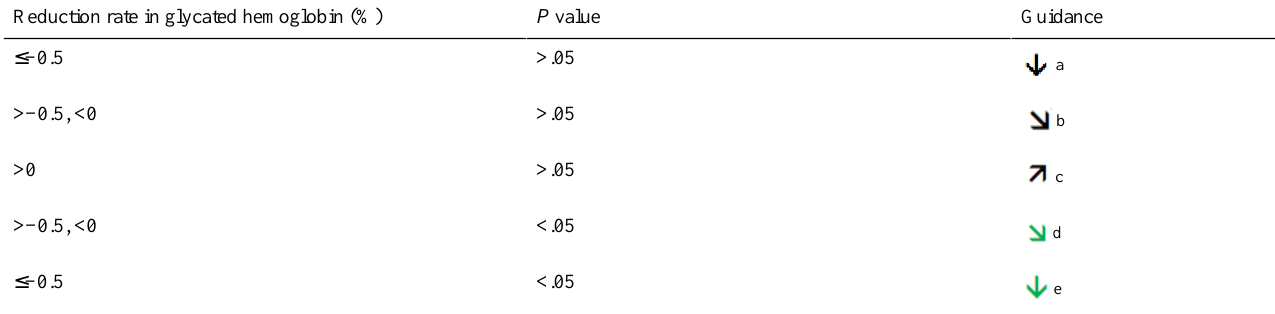
Table 2. Definition of clinically relevant differences in glycated